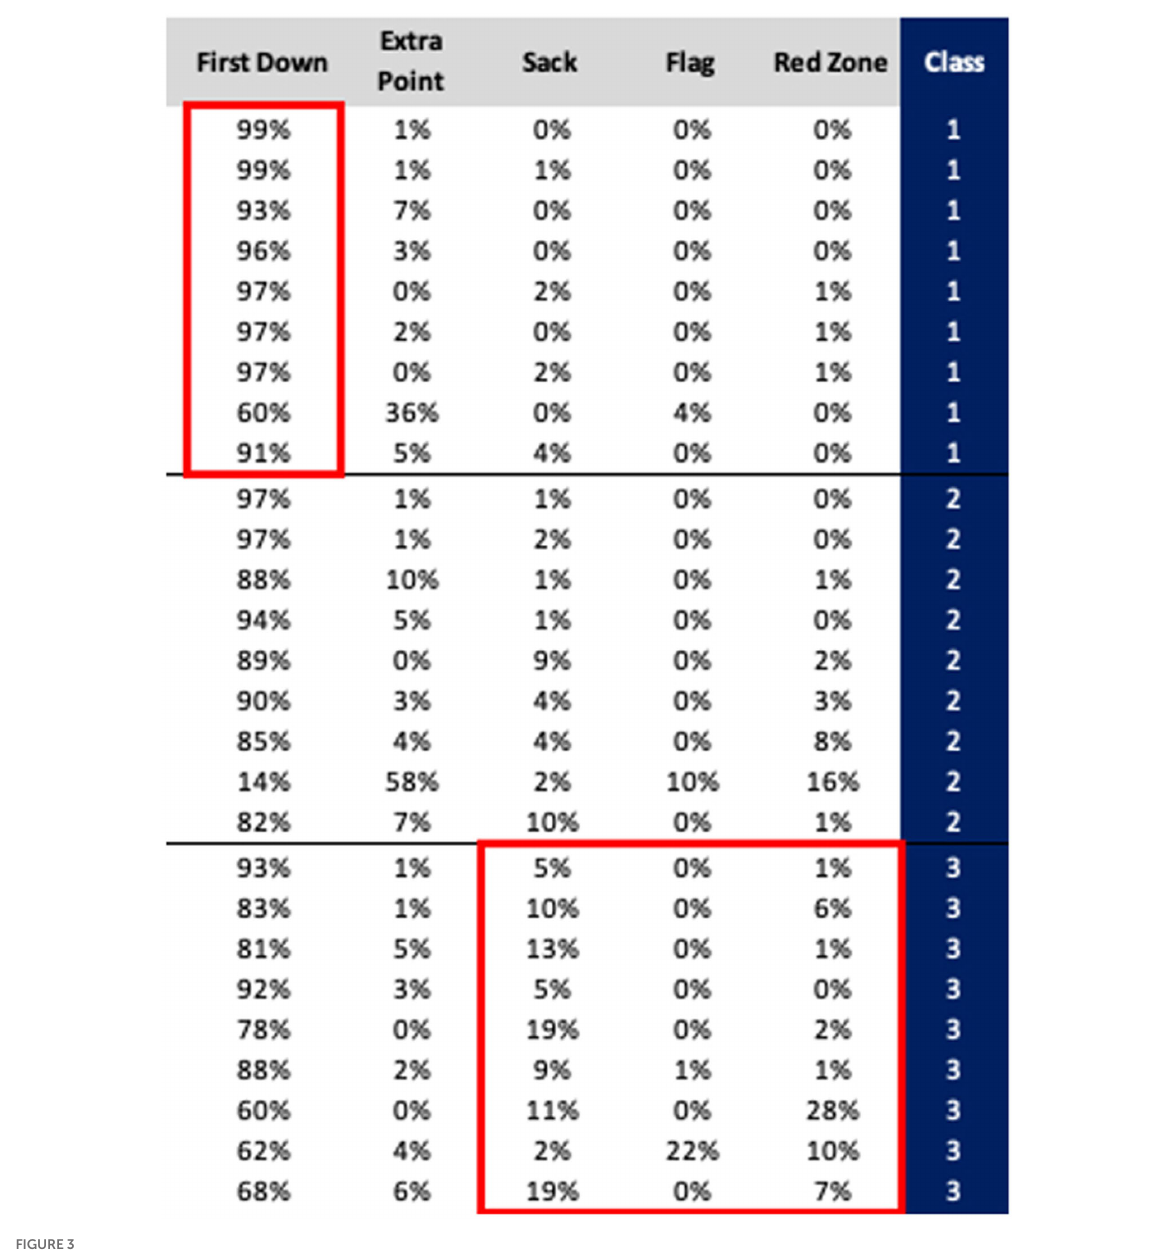
FIGURE 3 Average cluster centers per